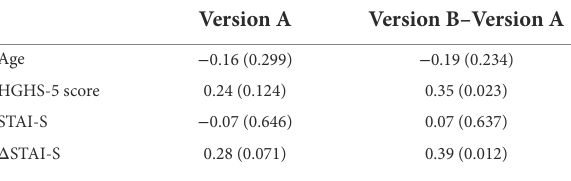
TABLE 4 Factors influencing the effect of risk information on maximal arm muscle strength and on its modification with an alternative